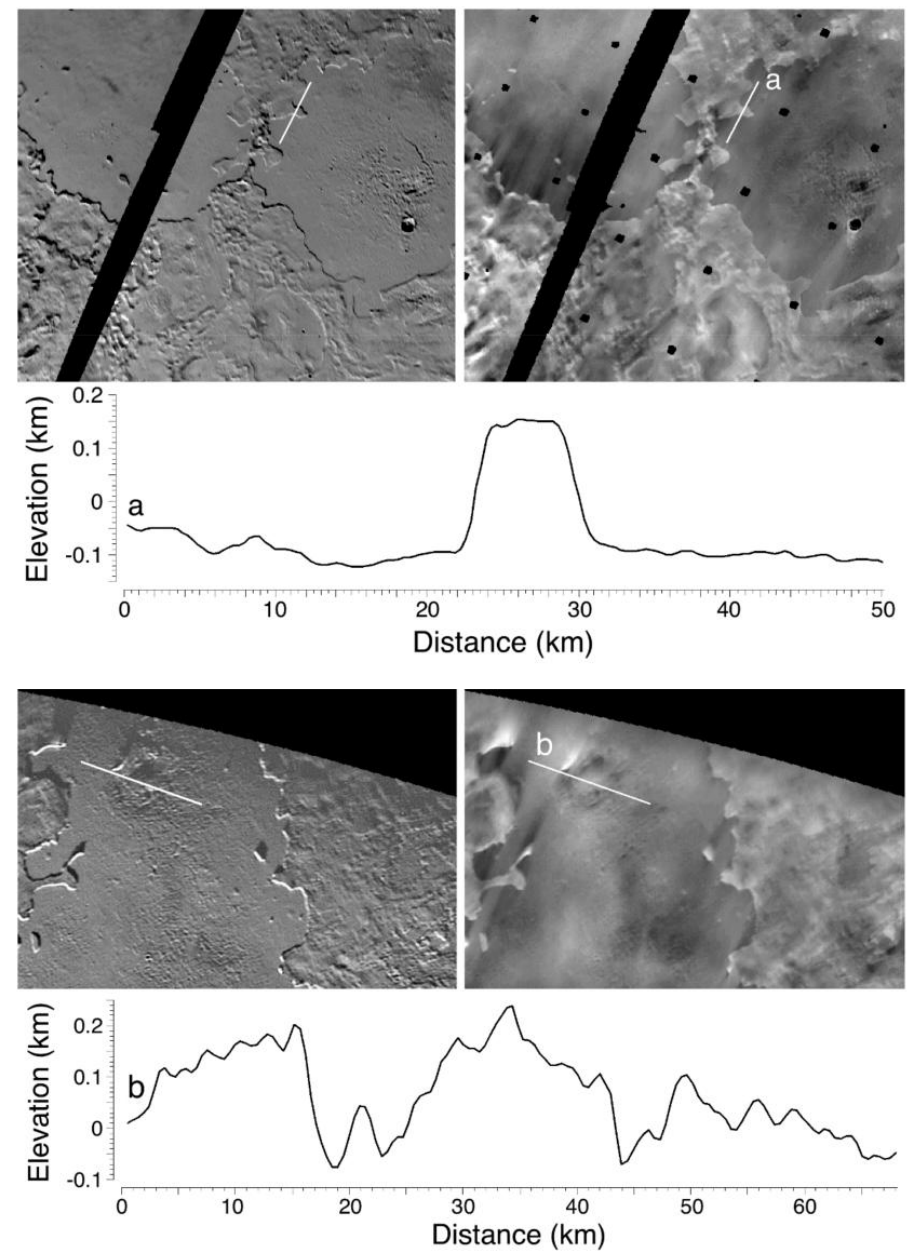
Figure 14. Topographic profiles across the margin of Ruach Planitia ( a ) and central pits of the Tuonela Planitia ( b ). Subtle undulations on the floor of the walled plains are within the stereoscopic uncertainty limits of the SG-DEM layer and might not be real. ( top ) Image mosaic and ( right ) DEM scene widths are ~290 km from SG-PC-DEM in Figure 8. Note different horizontal scales in profiles. North of Ruach Planitia lies a complex knobby terrain cut by several sinuous and intersecting channels <10 km wide and ~200 m deep (Figure 15), one of which merges with northern Ruach Planitia. These are the only examples recognized on Triton and suggest that northern areas in darkness in 1989 are geologically complex. These channels are reminiscent of several eroded channels that flow into Sputnik Planitia (see Triton–Pluto Comparisons section